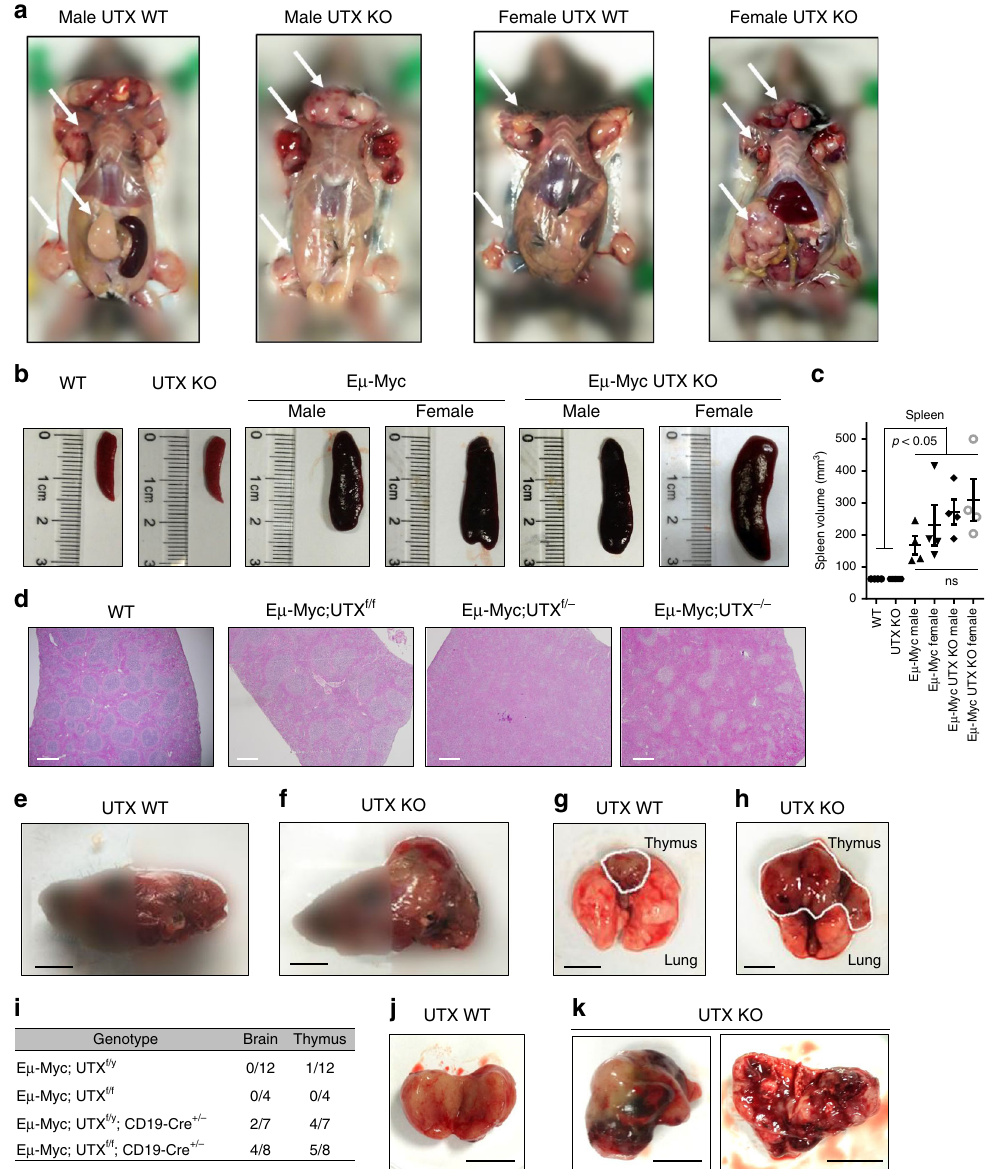
Fig. 2 Lymphomas in E μ -MYC;UTX KO mice exhibited enhanced aggressiveness. a Representative images of lymphoma-bearing mice. b Representative images of spleens for each genotype. c Spleen volume of each genotype. Shown are mean ± SEM, n = 4 for each genotype. d Representative HE staining images of spleens of each genotype, Bar, 500 μ m. e , f Normal skull in UTX WT mice and skull bulges in UTX KO mice. g , h Normal thymus in UTX WT mice and enlarged thymus in UTX KO mice. i Summary of extranodal lymphoma in brain and thymus. j , k Representative images of lymphomas in UTX WT mice ( j ) and UTX KO mice ( k ). In Panel k , image in the right is a cut-open lymphoma showing blood vessels. Bar, 5